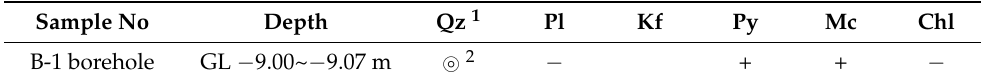
Table 7. X-ray diffraction results.